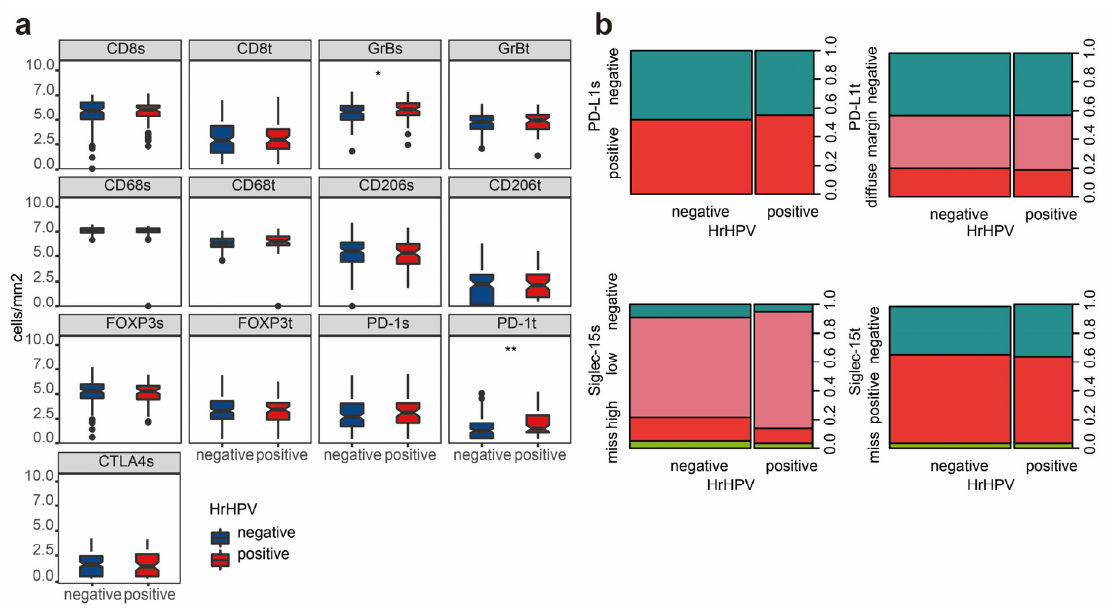
Figure 2. The expression of immune markers in hrHPV − and hrHPV + samples. ( a ) The box plots indicate the transformed densities of stromal CD8 (CD8s), intratumoral CD8 (CD8t), GrBt, GrBs,CD68t, CD68s, CD206t, CD206s, FOXP3t, FOXP3s, PD-1t, PD-1s and CTLA-4s. Compared with the hrHPV − patients, the hrHPV + patients expressed a higher density of stromal GrB and intratumoral PD-1. * p < 0.05, ** p < 0.01, independent t-test. ( b ) Spineplot diagrams show the expression patterns of PD-L1 and Siglec-15 in the intratumoral and stromal regions. There was no di ff erence between the expression of PD-L1 and Siglec-15 between hrHPV − and hrHPV + tumors.